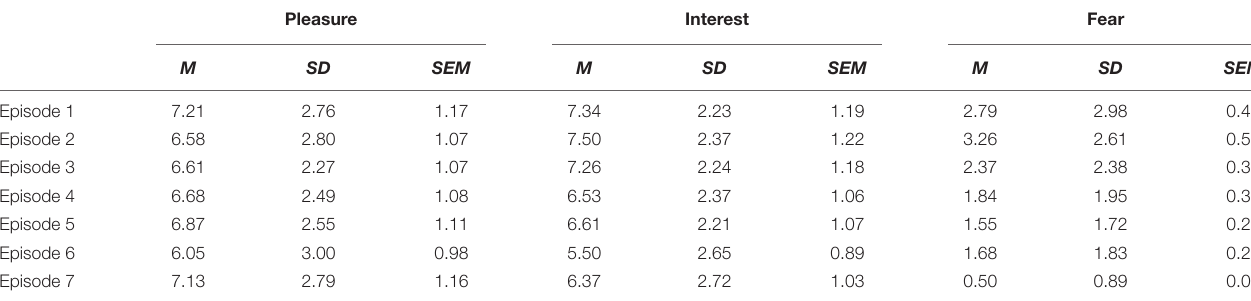
Pleasure Interest Fear M SD